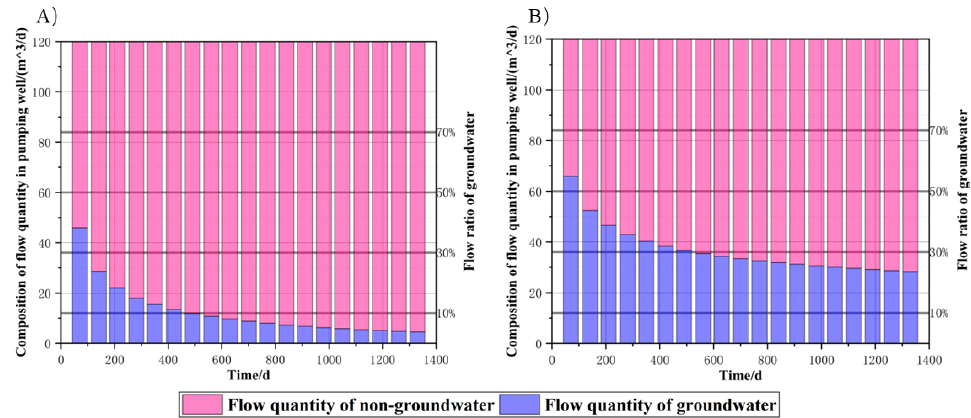
Figure 8. The bar graph of composition of flow quantity in pumping well BC2401 with the change in time. Note: ( A ) ‐ Plan A; ( B ) ‐ Plan B.